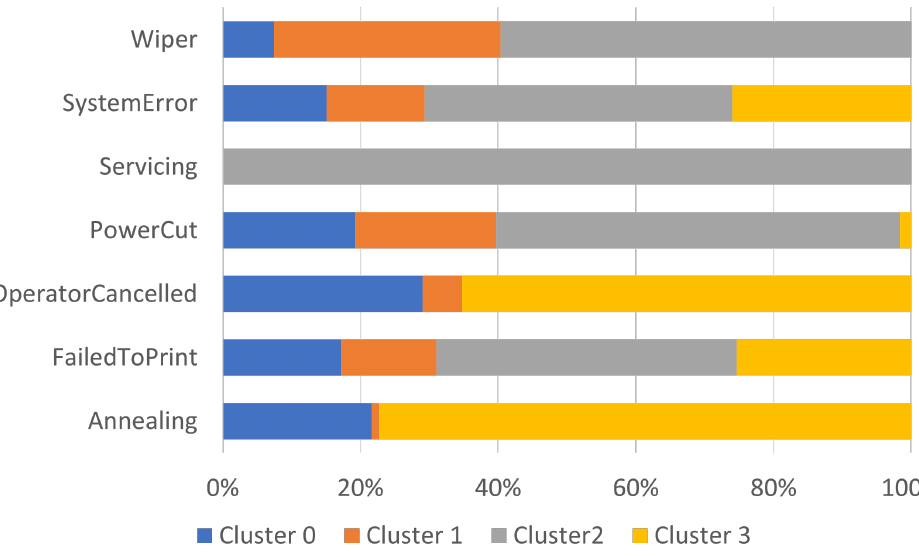
Figure 11. Job failure